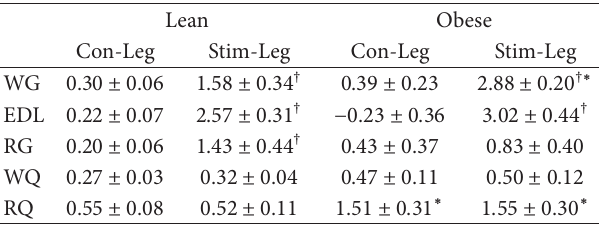
Results represent mean ± SEM ( 𝑛 = 6 per group). † 𝑃 < 0.05 versus Con-Leg (paired 𝑡 -test, effect of sciatic nerve stimulation, within group), ∗ 𝑃 <